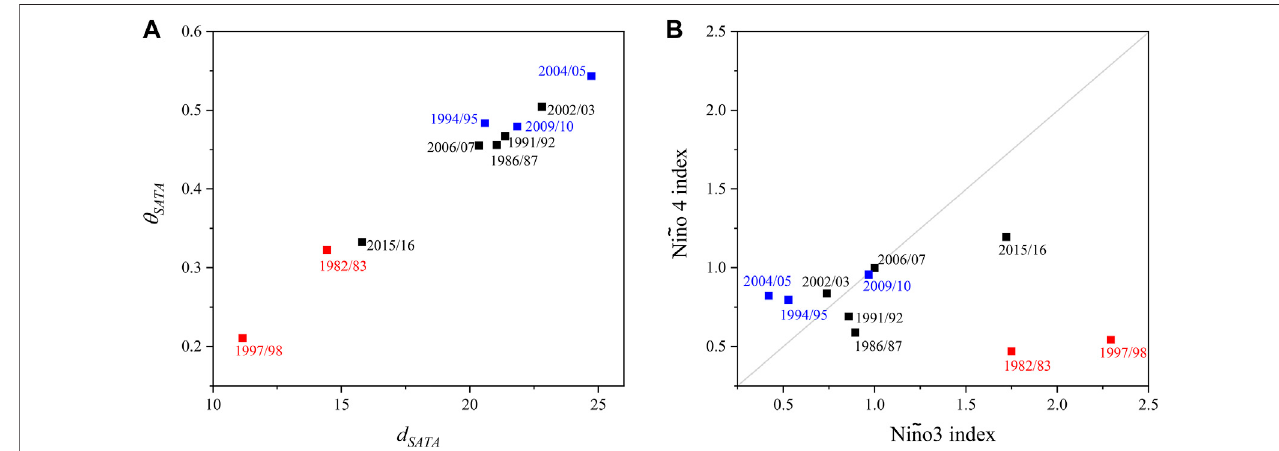
FIGURE7| ComparisonofdifferentElNiñoevents. (A) Scatterplotsof θ SATA versus d SATA intermsofthemeanvaluesduringeachElNiñoevent. (B) Scatterplotsof